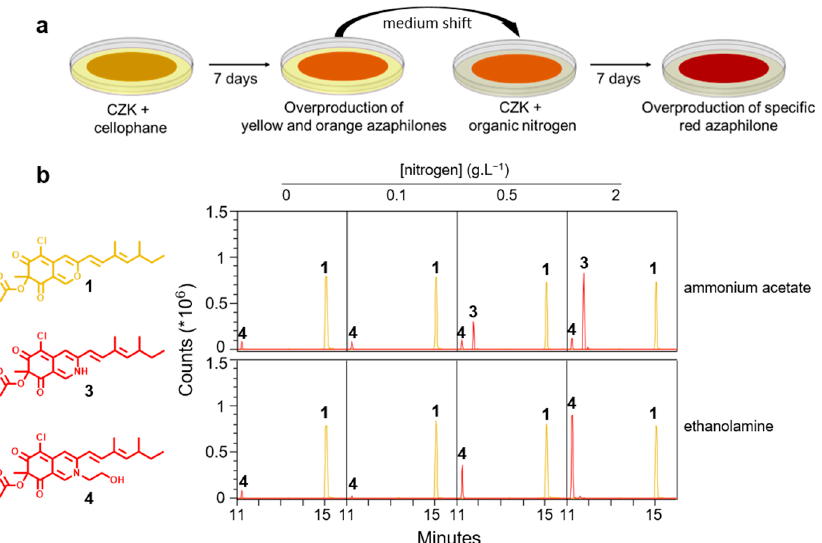
Figure 3. Specific incorporation of functionalized nitrogen into azaphilones. ( a ) Two-step solid-state cultivation on porous Cellophane membrane to achieve specific red azaphilone pigments overproduction by P. sclerotiorum SNB-CN111 and ( b ) extracted ion chromatograms for molecules 1 ([M + H] + , m / z 391.1307), 3 ([M + H] + , m / z 390.1467) and 4 ([M + H] + , m / z 434.1729) as a function of the concentration of ammonium acetate or ethanolamine added to CZK medium.